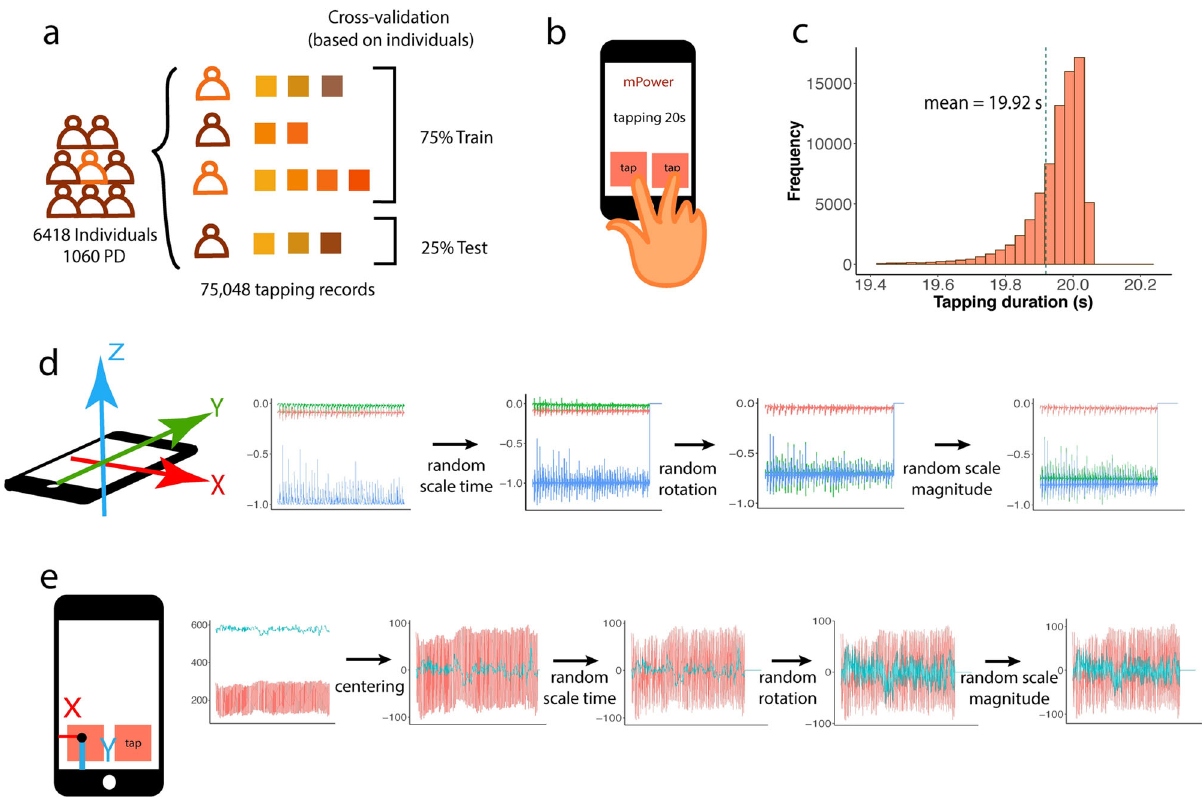
Fig. 1 Summary of tapping data and preprocessing techniques. a Training and test data are separated by individuals to avoid contamination. b Participants were asked to tap successively in turns on the screen of the phone for 20 s. Machine learning models are trained for accelerometer and coordinate data separately. c Distribution of the length of the records ( d , e ) demonstrate the preprocessing and augmentation techniques for raw accelerometer and coordinate data. Normalization/centering, random time scaling, rotation, and magnitude scaling were applied in a sequential order. At the last step, magnitude scaling was applied to each channel of the accelerometer and coordinated